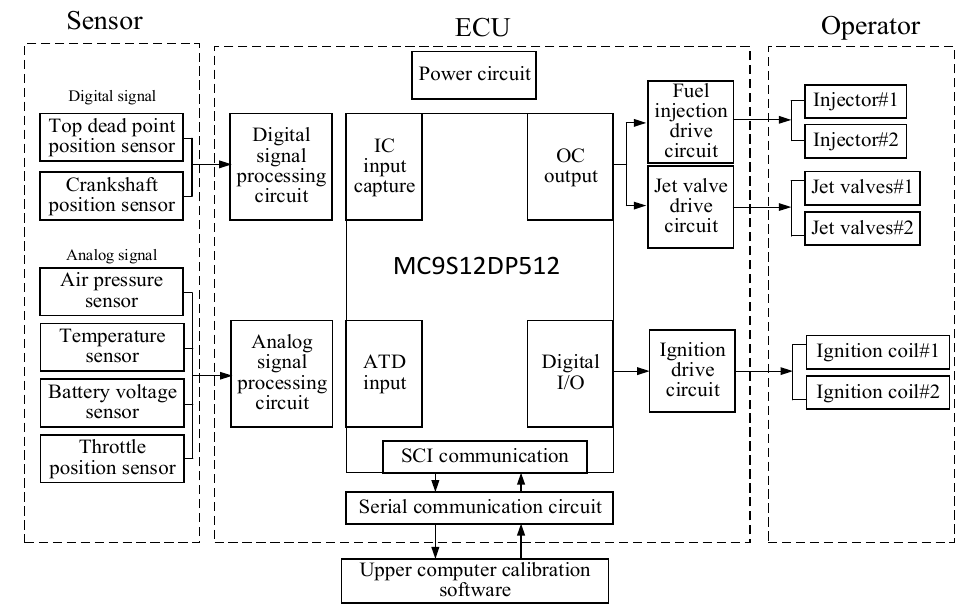
Figure 1. Structure block diagram of the prototype electronic control system.